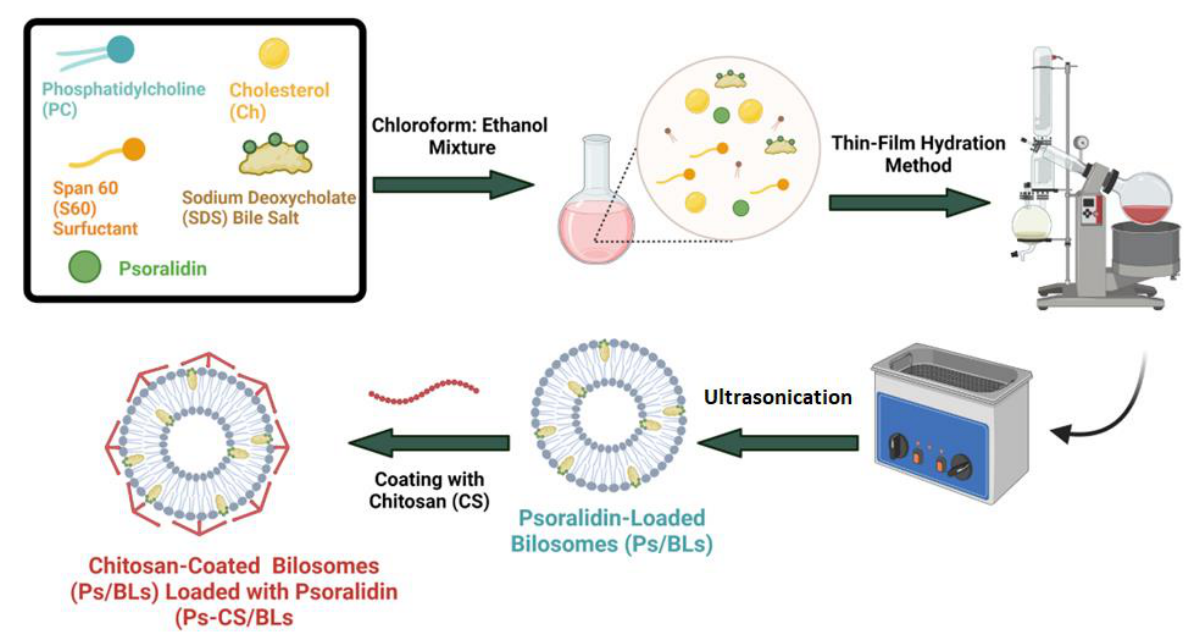
Scheme 1. Schematic diagram illustrating the steps involved in the design of surface-modified bilosomes loaded with psoralidin (Ps). Table 1. The particle size, PDI, zeta-potential, and EE% of different uncoated and chitosan-coated bilosomal formulas. All measurements were carried out in triplicate, and the data are expressed as means ± standard